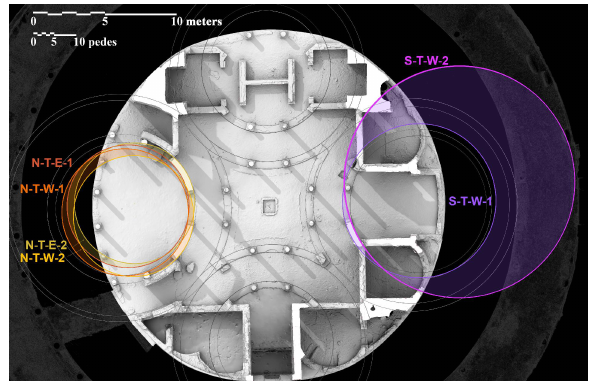
Figure 13. Circumferences of reconstructed